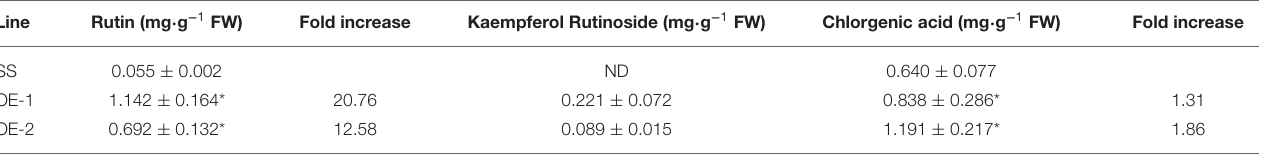
TABLE 2 | Quantification of major polyphenolics in wild-type and AtMYB12 overexpression tobacco leaves.